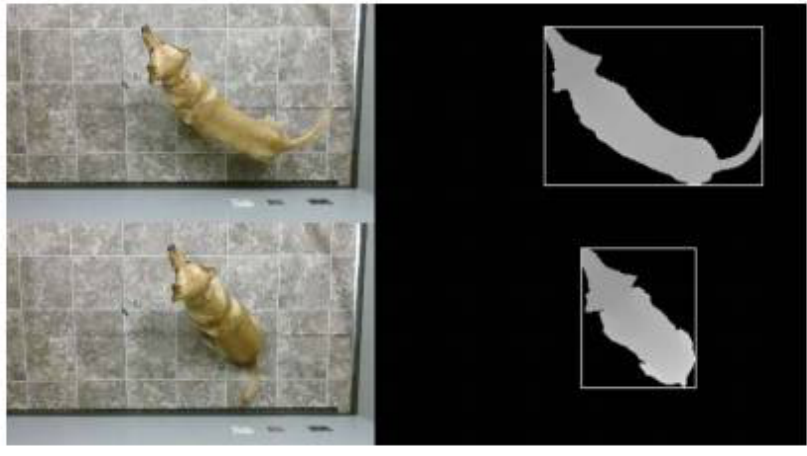
Figure 12. Tracking dogs using posture recognition via an Xbox Kinect [114].